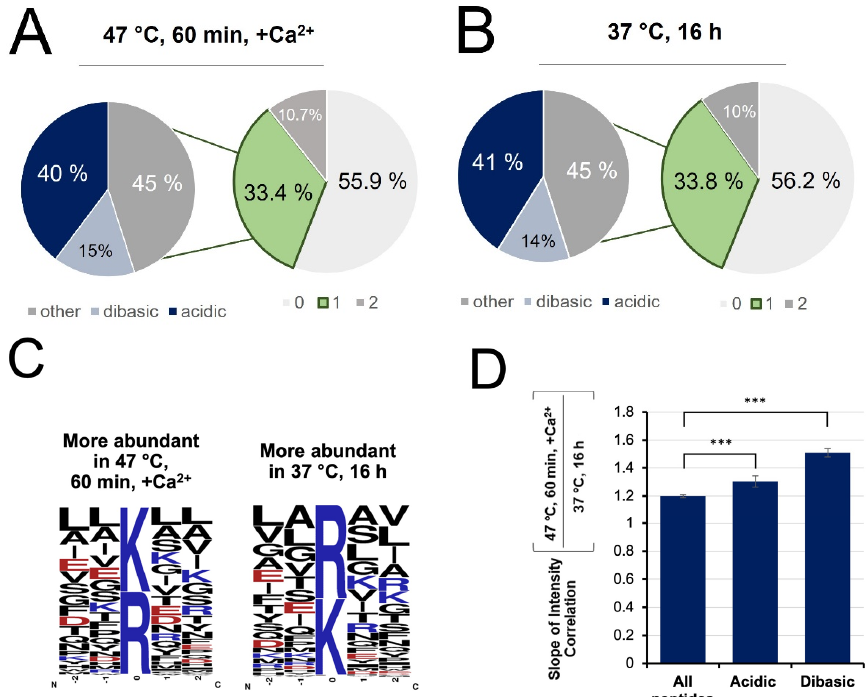
Figure 9. Singly miscleaved peptides identified in ( A ) the rapid digest and ( B ) conventional digest were further classified based on the nature of the missed cleavage site, with 55% of singly miscleaved peptides attributed to acidic or basic residues immediately adjacent to the cut site. ( C ) Motif diagrams highlighting the frequency of acidic and basic residues being within 2 residues of the C-terminal cleavage site. ( D ) Comparison of the slopes correlating peptide intensity in the rapid vs. conventional digest for all peptides, those whose C-terminal cleavage site is adjacent to an acidic residue and those whose C ‐ terminal cleavage site is adjacent to another lysine or arginine (*** p < 0.001).